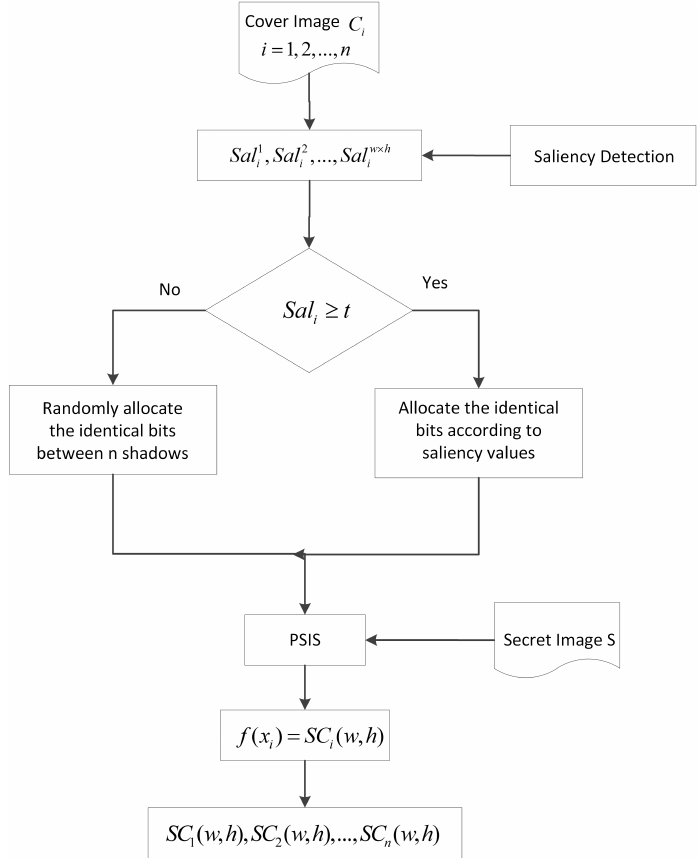
Figure 2. The main idea of the proposed scheme.